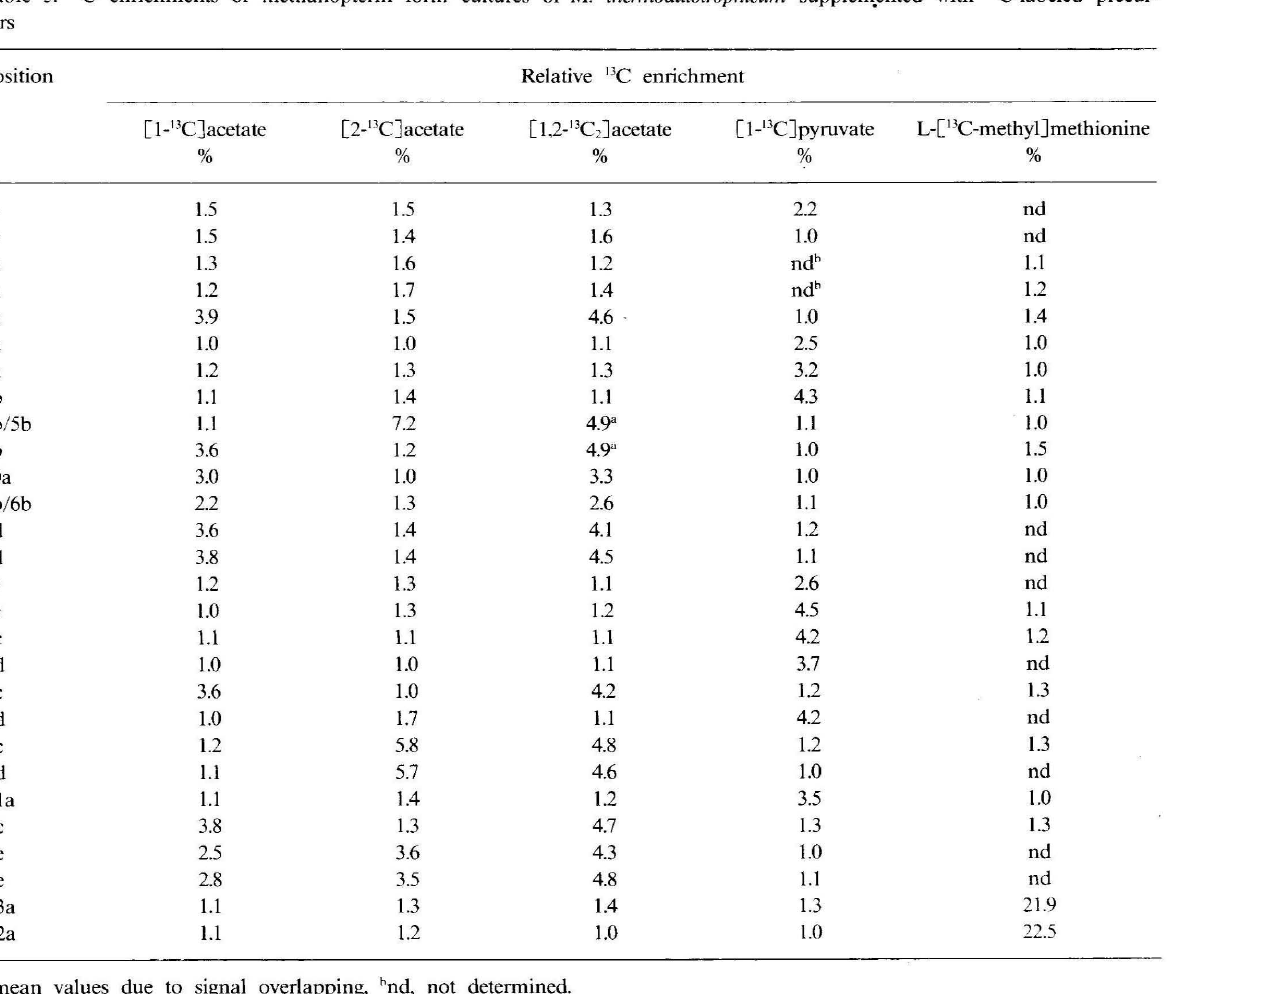
"mean values due to signal overlapping, hnd, not determined.